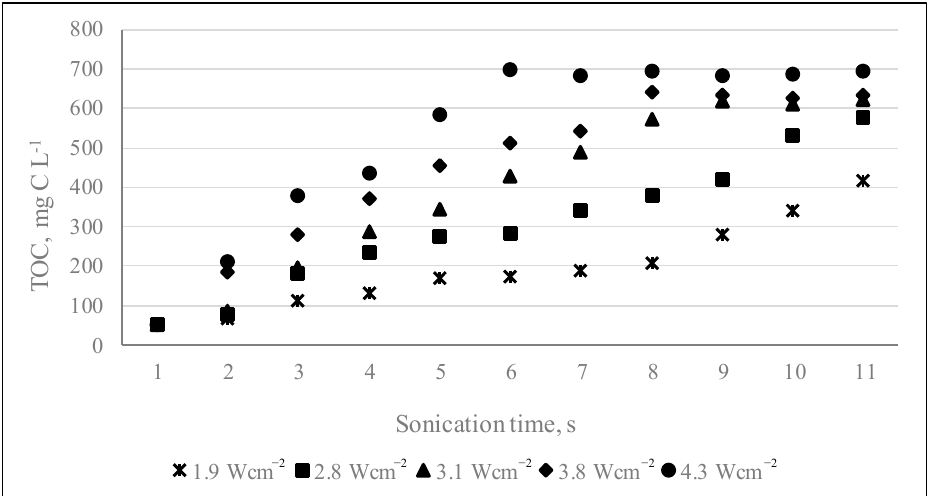
Figure 3. Changes of the TOC values in the ultrasonic disintegration process for the tested ultrasonic field intensity values depending on the sonication time.